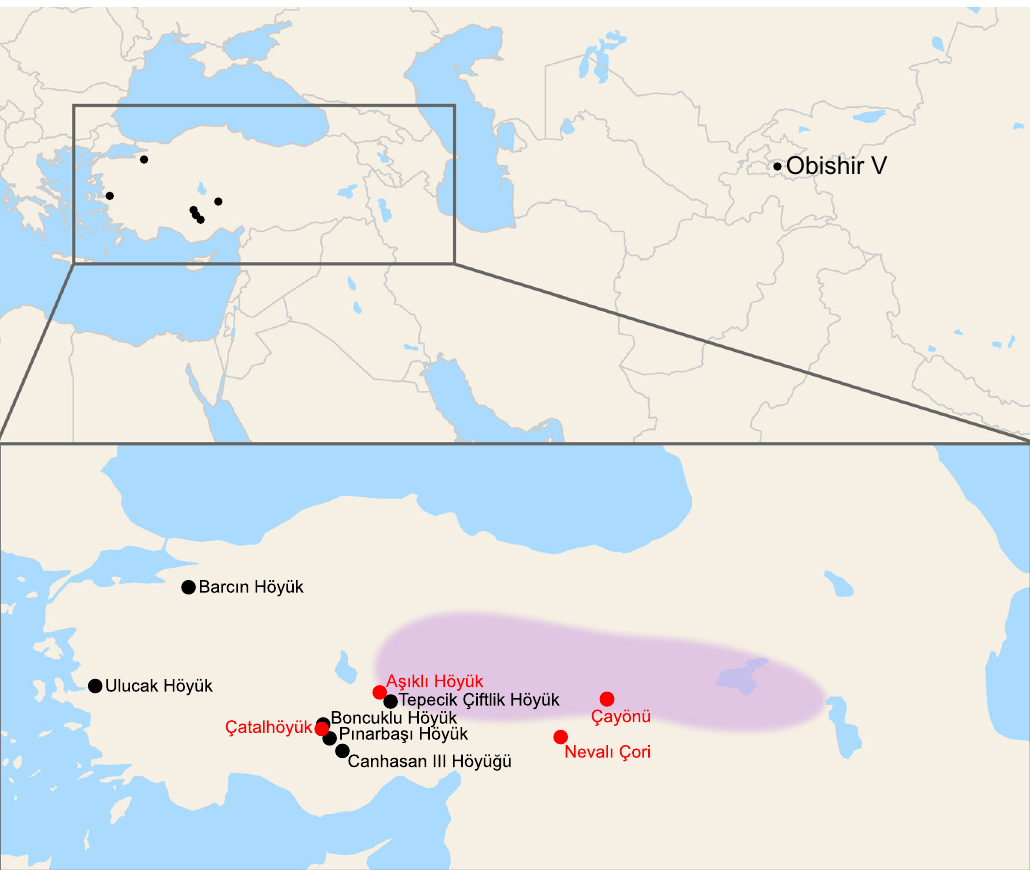
Fig. 1 Map of archaeological sites. Geographic origins of samples from six Anatolian archaeological sites studied in the present work (see Supplementary Note 2 for details) and one Kyrgyzstan archaeological site from Taylor et al. 20 are shown in black. Four additional Neolithic Anatolian sites relevant for sheep domestication discussed in the text are shown in red. The putative domestication center is depicted by the shaded area (adopted from Zeder 5 ).